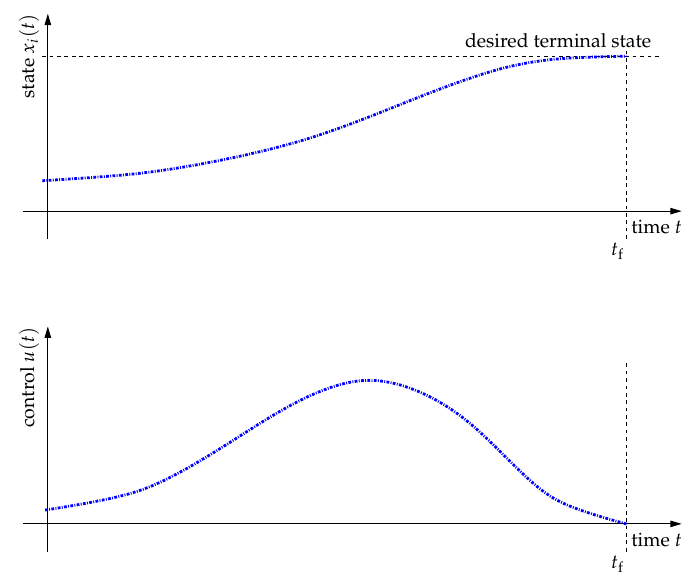
Figure 2. Computation of the optimal feedforward control u ( t ) = u ∗ ( r ) for the complete optimization horizon [ t 0 ; t f ] with the predicted optimal state trajectory x i ( t ) , i ∈ { 1, . . . , n }